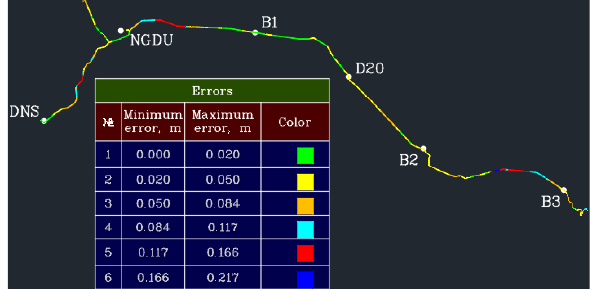
Figure 5. Error distribution for MLS data using check points every 1 km and without control points